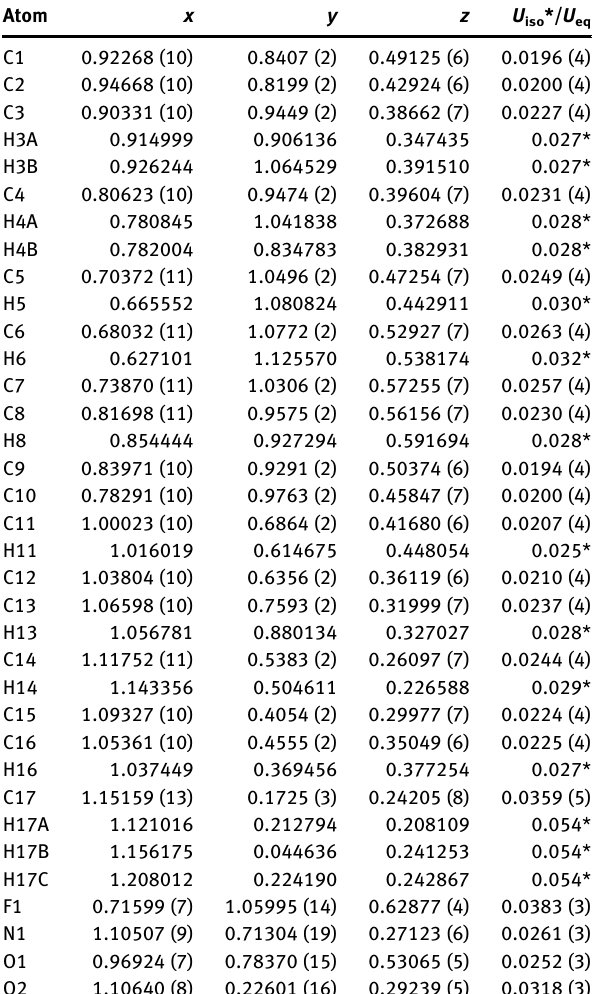
Table  : Fractional atomic coordinates and isotropic or equivalent isotropic displacement parameters (Å 